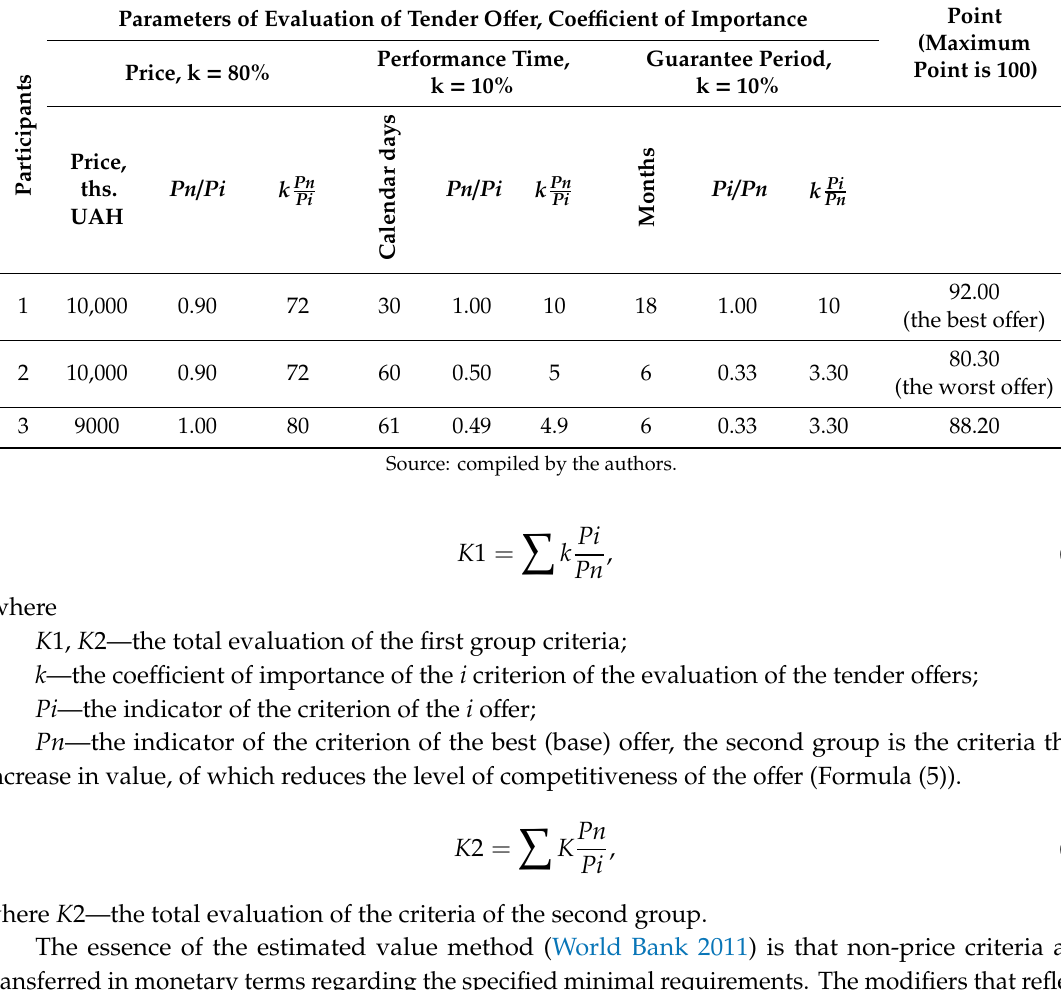
Table 5. Evaluation of the tender o ff ers by the comparative